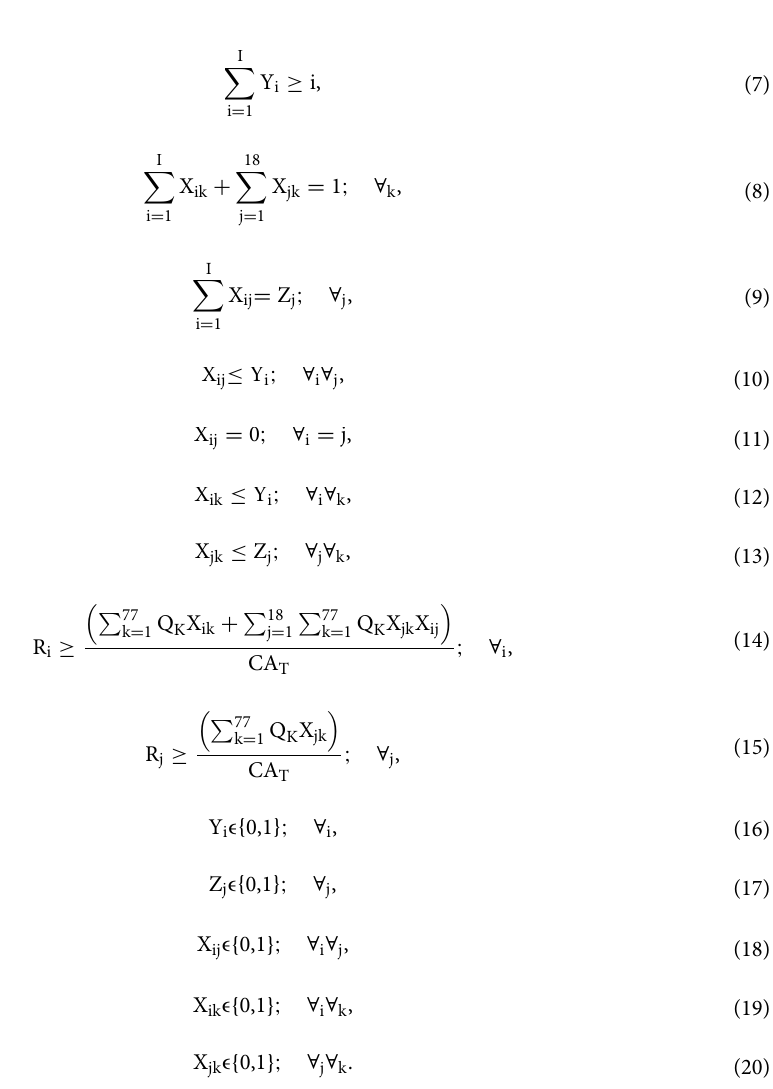
Table 3. Alternative locations for the storage areas and